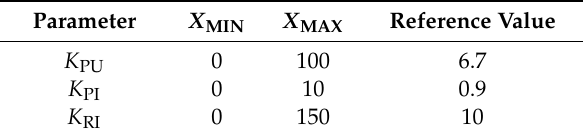
Table 2. Solution space boundary condition and reference value.